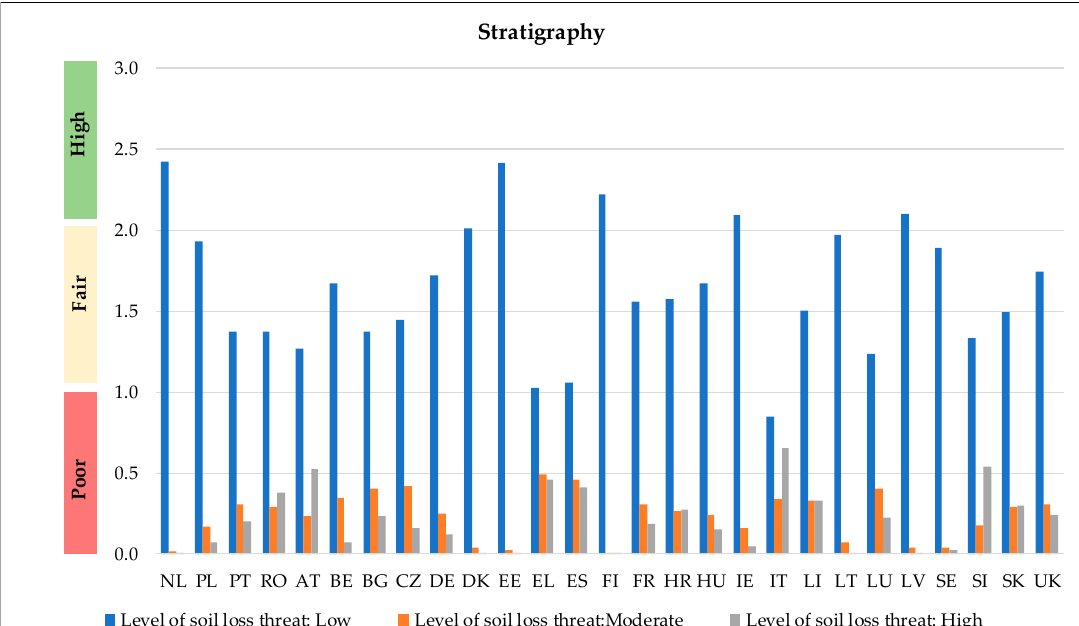
Figure 10. Mean values per country level for bones per level of soil-loss threats: Values close to 1 indicate poor status of preservation, values close to 2 indicate fair conditions of preservation, and values close to 3 good preservation